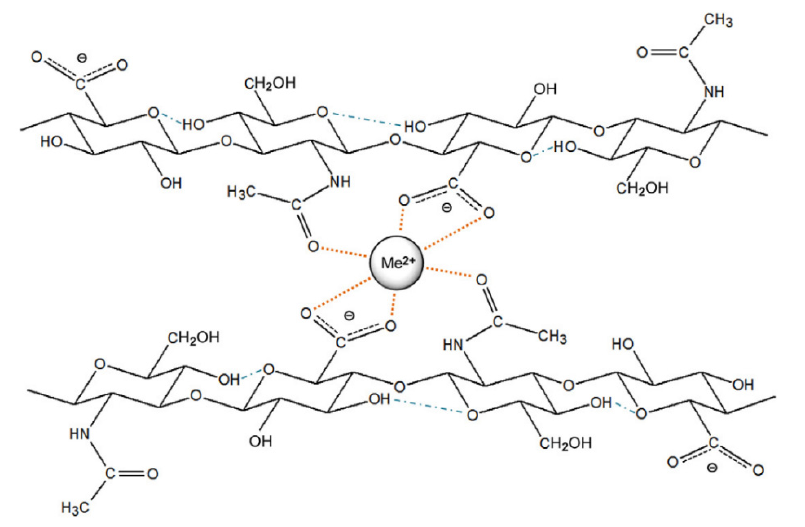
Figure 3. Formed chelate structure between a bivalent cation and two disaccharide units. Used with permission from reference [59] .